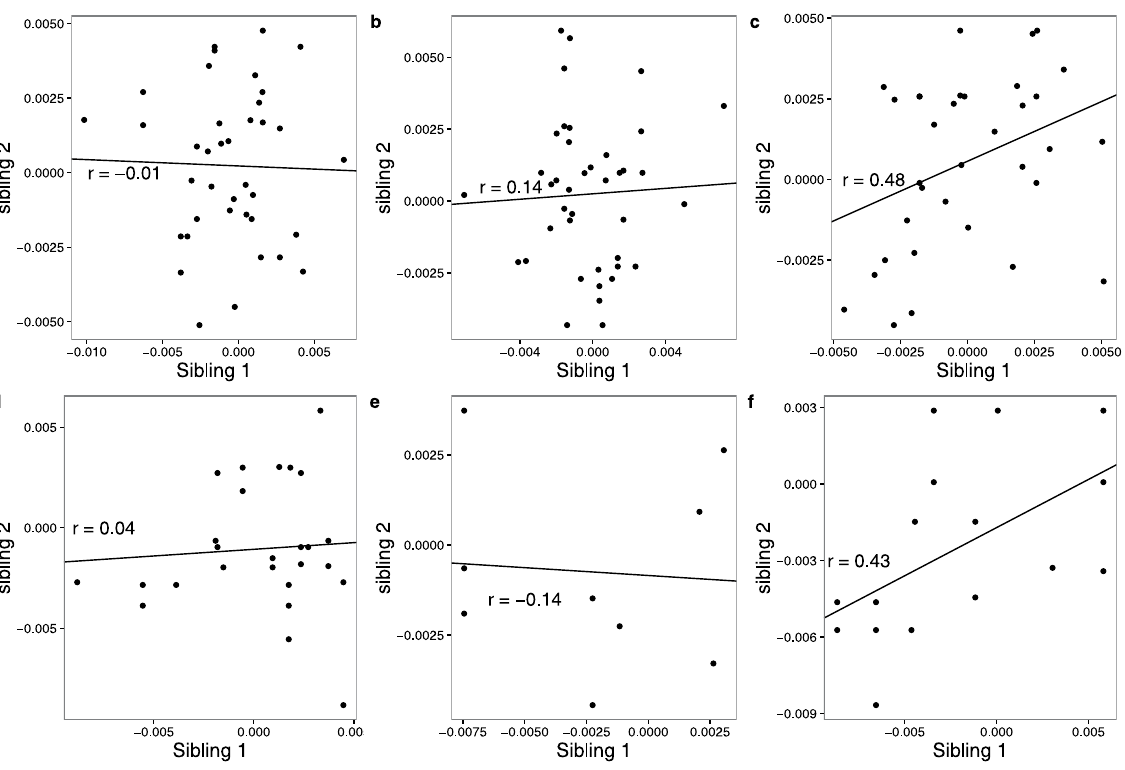
Figure 1. Correlations in GWAM for different types of sibling pairs in the AMDTSS and KHTS ( a ) Pairs of BT siblings in the AMDTSS. ( b ) Pairs of B/AT siblings in the AMDTSS. ( c ) Pairs of AT siblings in the AMDTSS. ( d ) Pairs of BT siblings in the KHTS. ( e ) Pairs of B/AT siblings in the KHTS. ( f ) Pairs of AT siblings in the